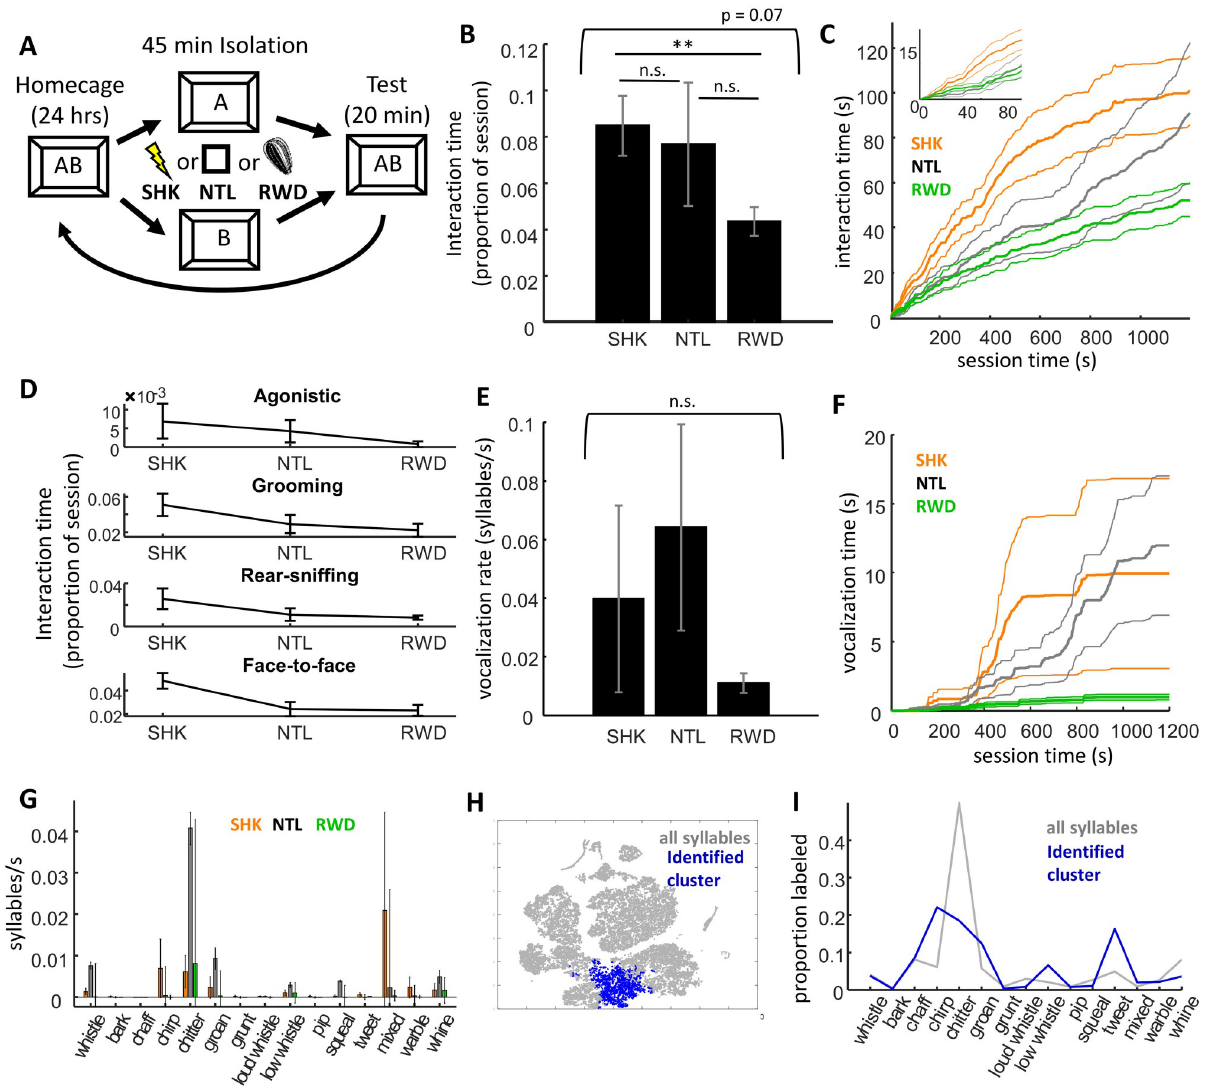
Fig 3. Effects of exposure to an acute stressor on reunion behavior. A) Experimental design. Degus (n = 9 dyads) were isolated for a 45 min period during which they were exposed to unexpected footshock (SHK), unexpected reward (sunflower seeds; RWD), or neither (NTL). B) Proportion of time dyads spent interacting in each condition. C) Cumulative distribution of time spent interacting across the session (thicker lines are means, thin lines standard error). Footshock stressor increased social interaction earlier during the testing, though this behavior leveled off in the latter half. D) Four line graphs depict the proportion of time degus spend interacting 10 min into the testing session across each of the three conditions. There was a general pattern for higher interaction across behavior types in SHK at the 10 min mark of the reunion. E) Vocalization rates (syllables per second) across conditions. Vocalizations rates were highly variable between dyads. F) Cumulative time spent vocalizing (y-axis) is plotted against session time (x-axis). Although there was high variance between dyads, the general pattern was for vocalizations to begin after several minutes of physical interactions, and to subsequently approximately follow the temporal patterns of physical interactions. G) Vocalization rates are plotted across each of 15 syllable categories. High variance made interpretation difficult, but generally rates of chitters seemed particularly high in NTL relative to SHK and RWD. H) Two dimensional t-SNE projection of syllable features, including those for all syllables (gray points) and those of the cluster of syllables found to be expressed more frequently in SHK. I) Proportion of syllables manually labeled across different category types, including all syllables (gray trace) and those syllables within the identified cluster (blue trace). The data suggest that chirp- and tweet-type vocalizations may be more common in degus recently exposed to a footshock stressor.